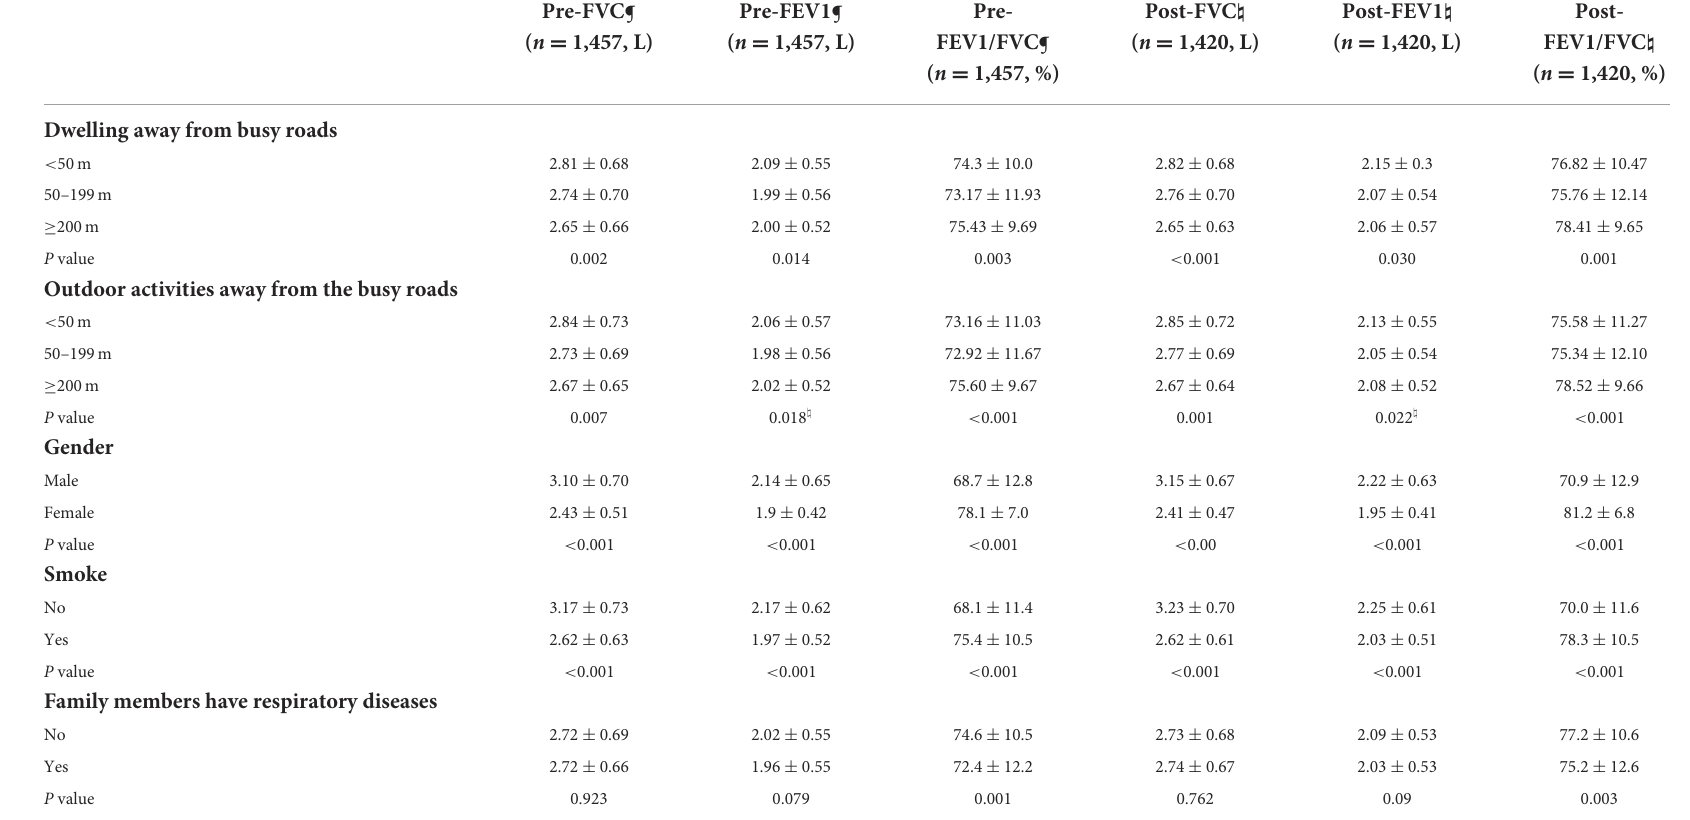
TABLE 2 Multivariate analysis of variance in pulmonary